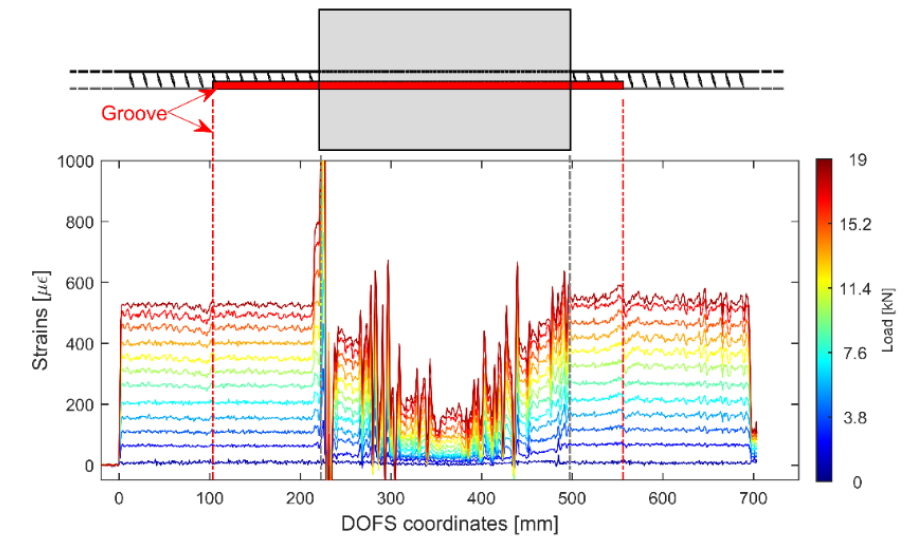
Figure 10. Strain profiles of a 15D20_27 RC tie test with the DOFS bonded with a combination of groove and CYN.